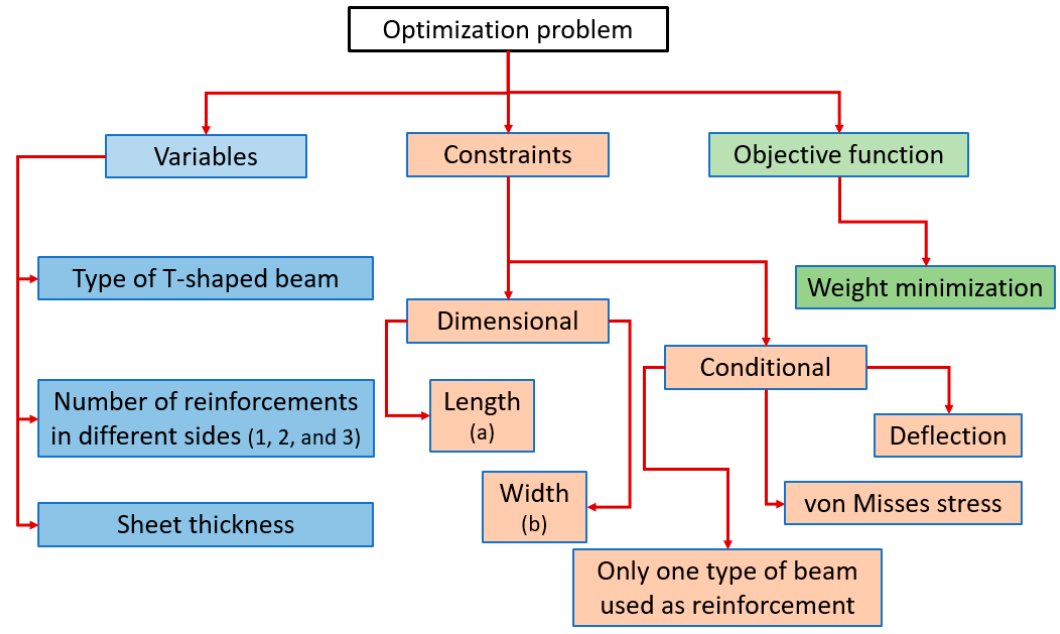
Figure 6. Details of the optimization process. Table 7. Details of optimum design for di ff erent cases of